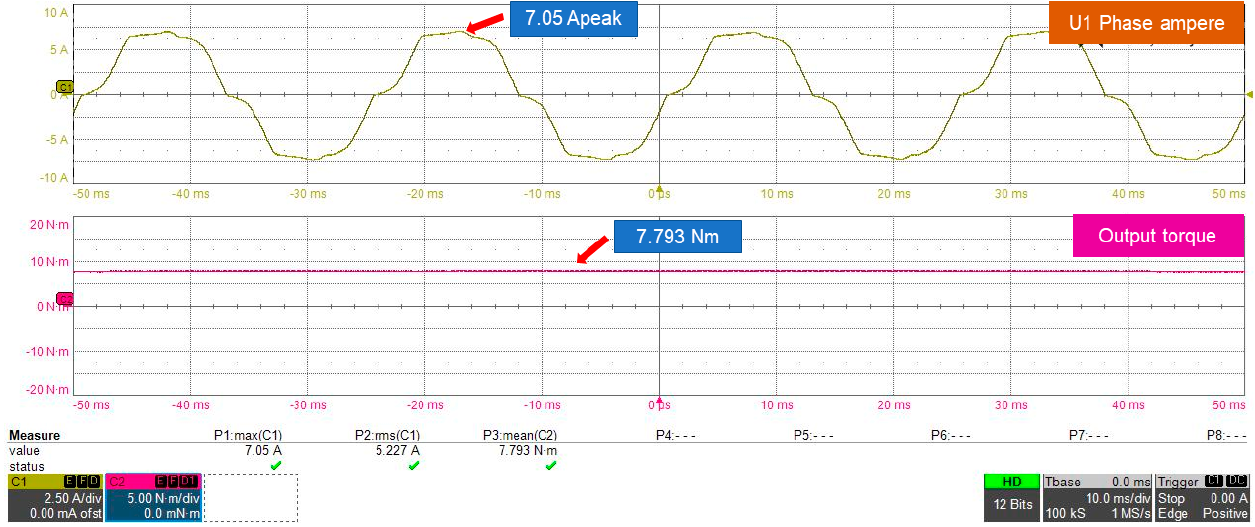
Figure 19. Torque curves at 480 r/min and 5 Arms for fifth-harmonic injection-controlled opera- tion.